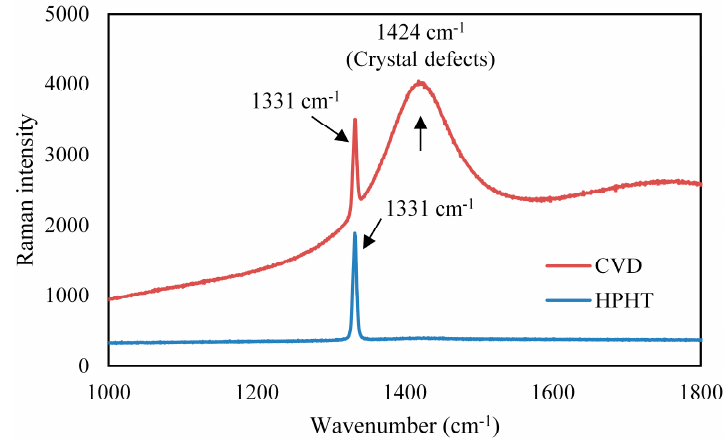
Figure 9. Raman spectra of the unirradiated surfaces, showing crystal defects in CVD.